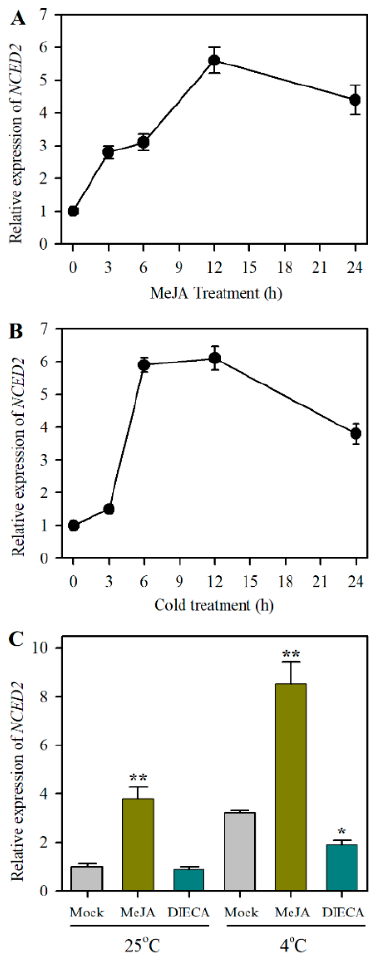
Figure 2. Expression of NCED2 in response to JA and cold stress. ( A ) Time course of NCED2 expression in response to MeJA treatment. ( B ) Time course of NCED2 expression during a 24 h cold treatment. ( C ) Changes in NCED2 expression as affected by exogenous MeJA and DIECA under cold stress. Tomato leaves were detached and floated on 50 µ M MeJA for 24 h. Leaf samples were collected at indicated time points and were used for the expression analysis of NCED2 by qRT-PCR. Tomato plants at the 4-leaf stage were subjected to cold stress at 4 °C for 24 h and leaf samples were collected at indicated time points for the expression analysis of NCED2 by qRT-PCR. Exogenous MeJA and DIECA were applied to tomato leaves 12 h prior to the cold treatment and the expression of NCED2 was determined by qRT-PCR following 24 h of cold stress. Data presented are means of three biological replicates ( ± SD). Asterisks indicate significant differences (** p < 0.01, * p < 0.05) according to Student’s t